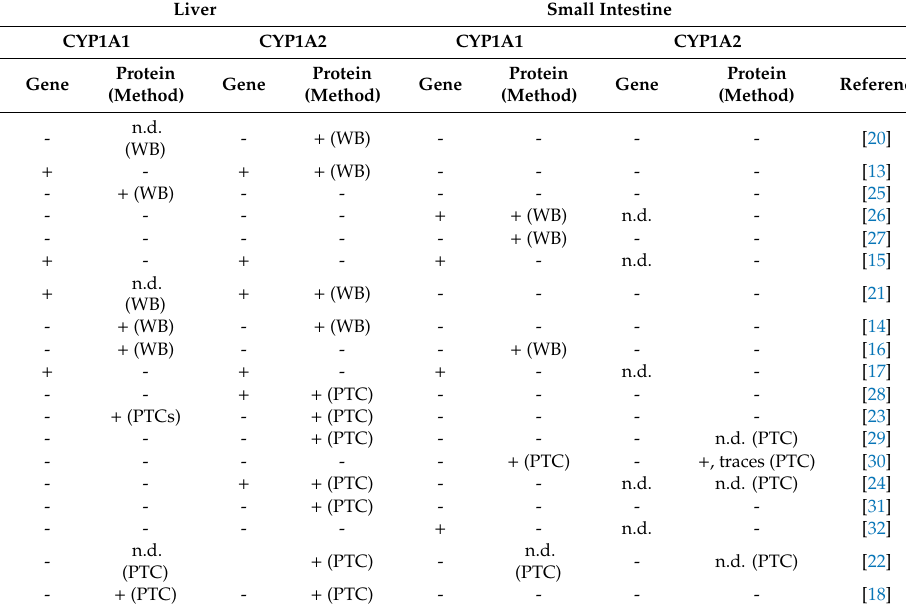
Table 1. Overview of available data on mRNA expression and protein abundance of cytochrome P450 (CYP) 1A1 and CYP1A2 in the human intestine and liver ( + , gene / protein expression was shown; -, not investigated n.d., not detectable; PTC, proteomics; WB, Western blot). Data are ranked